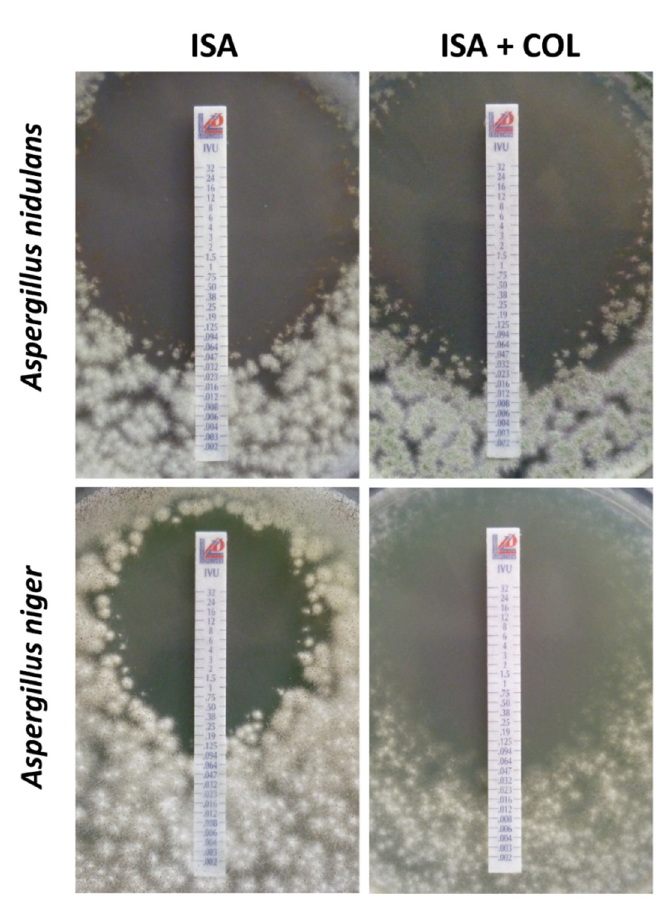
Figure 1. Interaction of isavuconazole and colistin vs. isavuconazole alone against A. nidulans isolate HEGP-3144 and A. niger isolate HEGP-6798 evaluated by agar diffusion assay. ISA, isavuconazole; COL, colistin; upper row, decrease of 1 log 2 in combination compared to isavuconazole alone; lower row, synergistic interaction with decrease of 2 log 2 in combination compared to isavuconazole alone.